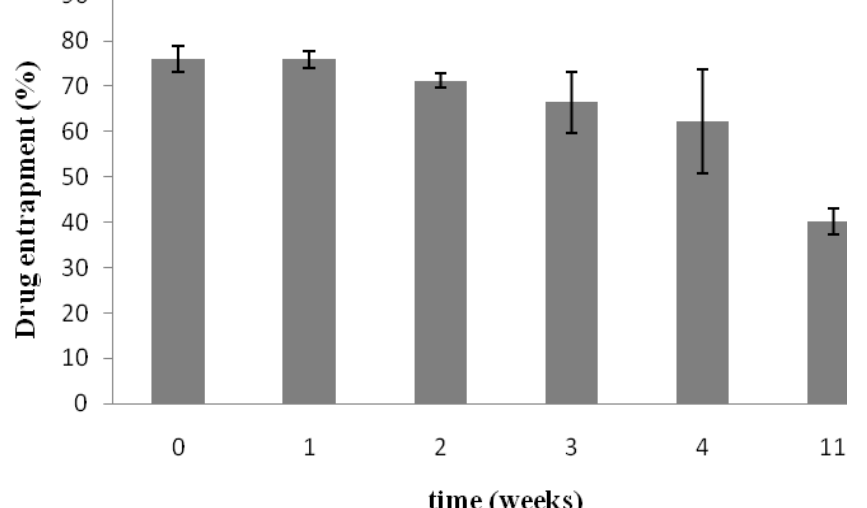
Figure 4. KT leakage from the elastic liposome formulation during storage (n =